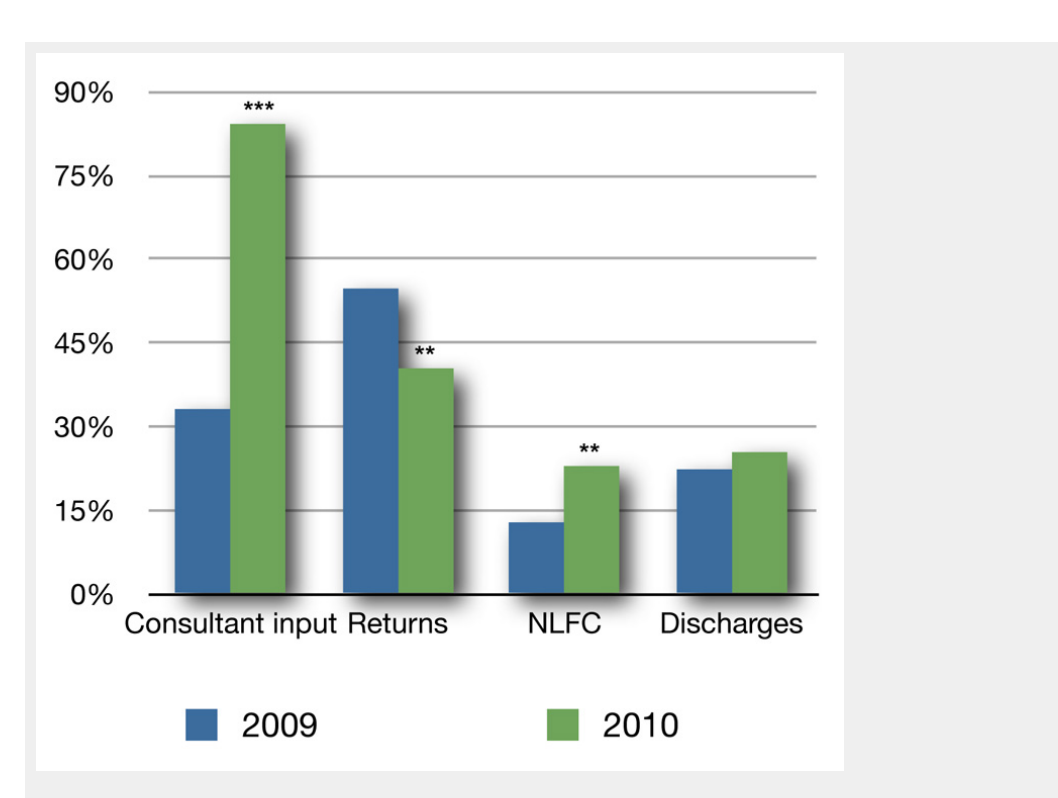
Figure 3 There were significant improvements in consultant input, use of the NLFC and a fall in return rates after the introduction of the new model of fracture clinic. Discharge rates increased, but did not reach significance. [NLFC = nurse-led fracture clinic; * = significant, (p <0.05); ** = very significant, (p 0.001–0.01); *** = extremely significant, (p